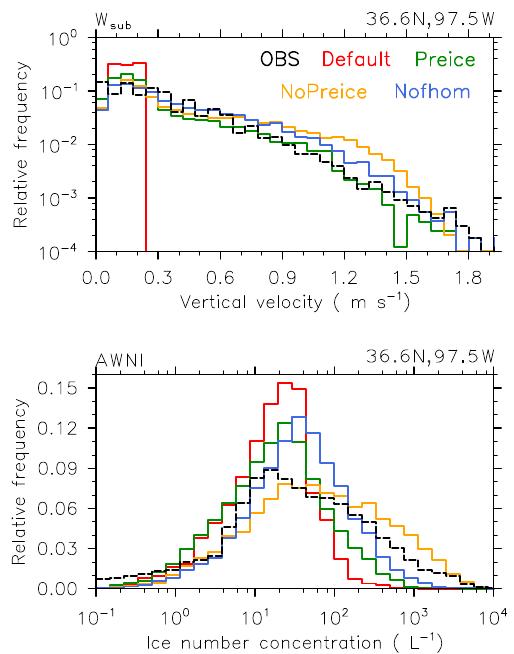
Figure 3. Probability distribution frequency of sub-grid updraft ve- locity ( W sub , upper panel) and in-cloud ice number concentration ( N i , lower panel) for Default, Preice, Nofhom and NoPreice ex- periments. Black dashed line refers to aircraft measurements from the SPARTICUS campaign. The observed W sub data were averaged over 50km × 50km grid (Zhang et al., 2013b). Model results are sampled over the field measurement site every